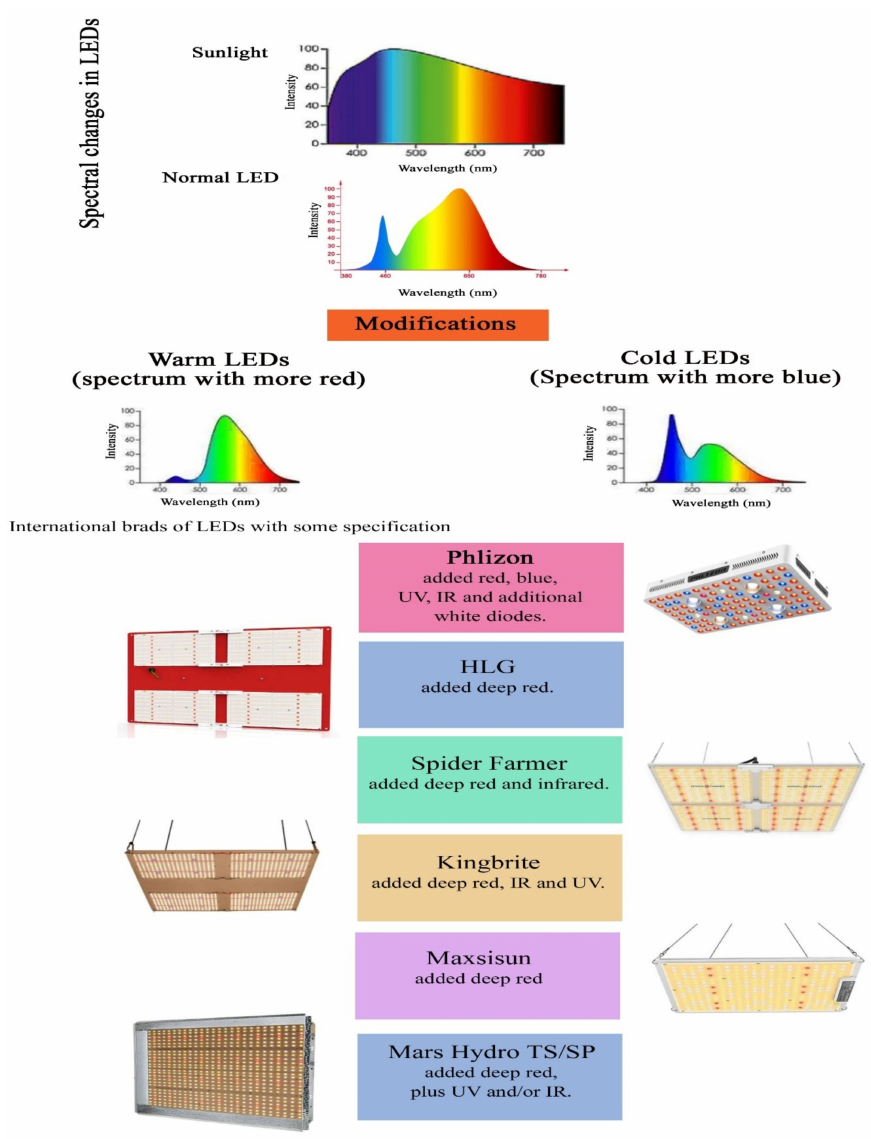
Figure 6. Spectral variations in LEDs from popular brands with major specifications. An analysis of the polyphasic Chl a fluorescence (OJIP) transients of Rosa hybrida cv. ‘Avalanche’ indicated the efficiency of white light over monochromatic illuminations